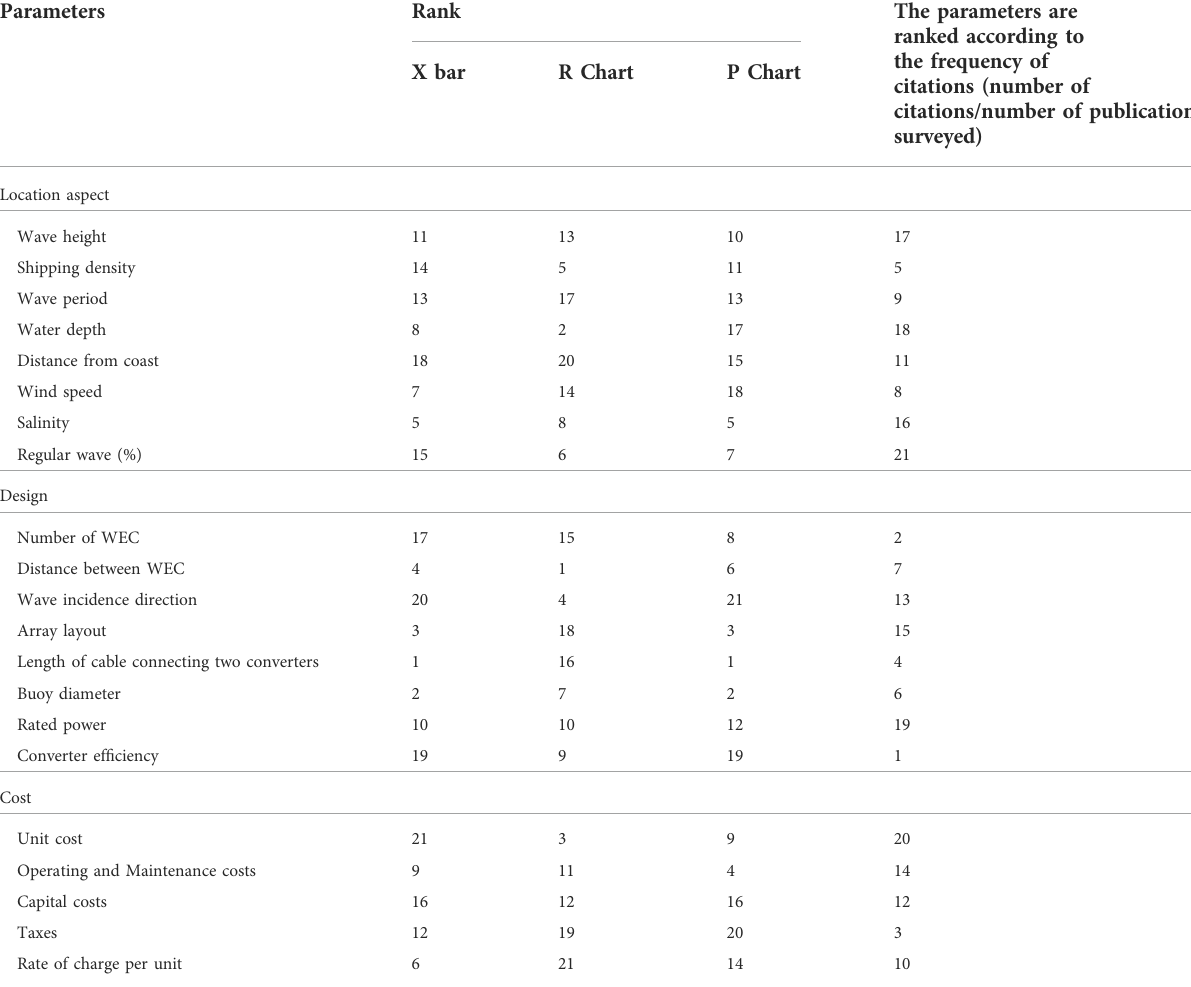
TABLE 3 Table showing the rank of the parameter of X bar, R, and P control chart. Parameters Rank The parameters are